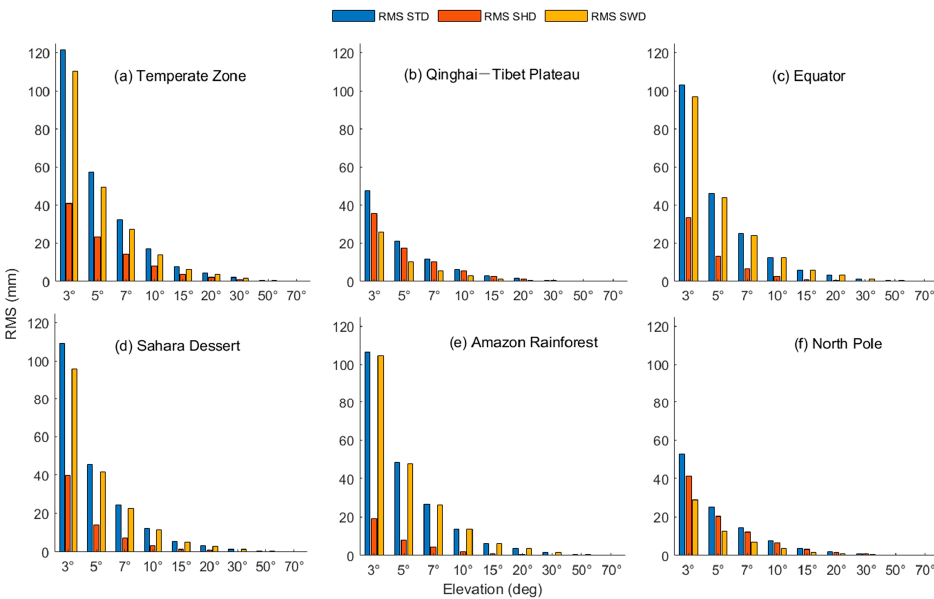
Figure 7. The RMSs of STD, SHD, and SWD for the six regions at the different elevations (70°, 50°, 30°, 20°, 15°, 10°, 7°, 5°, and 3°): ( a ) Temperate Zone ( b ) Qinghai—Tibet Plateau ( c ) Equator ( d ) Sahara Dessert ( e ) Amazon Rainforest ( f ) North Pole.